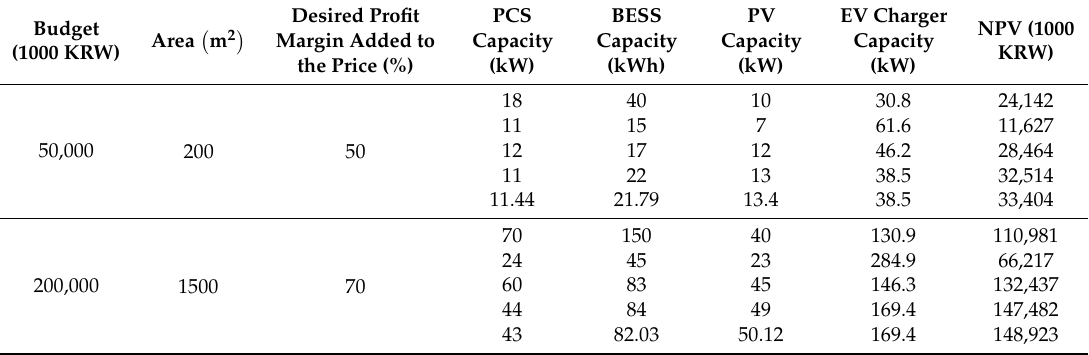
Table 10. Comparison between the NPVs for the arbitrarily selected capacities of equipment in Case A. Budget (1000 KRW)